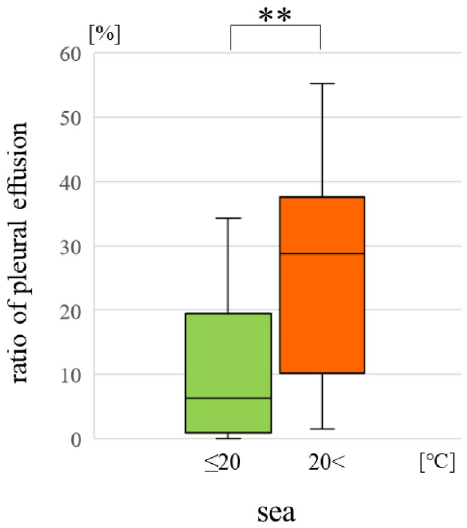
Figure 4. Comparing the intrathoracic weight and water temperature in the sea water group.